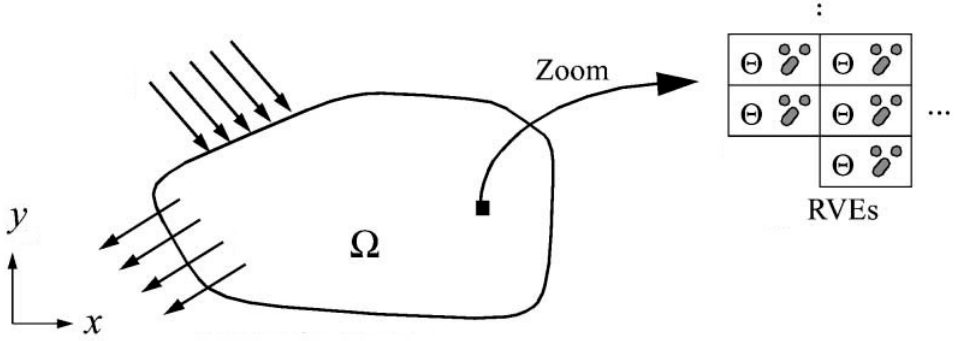
Figure 14. Macroscopic and microscopic structures of a component [93].